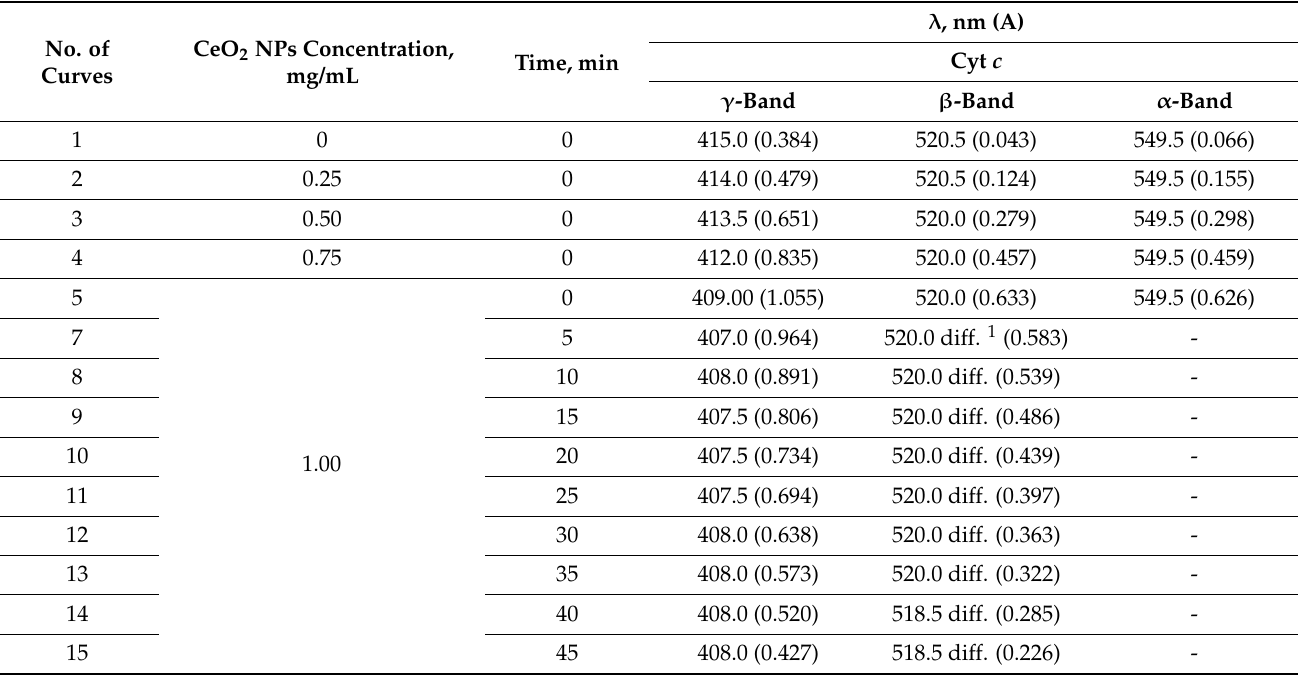
Table 2. Data from the UV-vis spectra of CeO 2 NPs (0.25, 0.5, 0.75, 1 mg/mL) and 0.0334